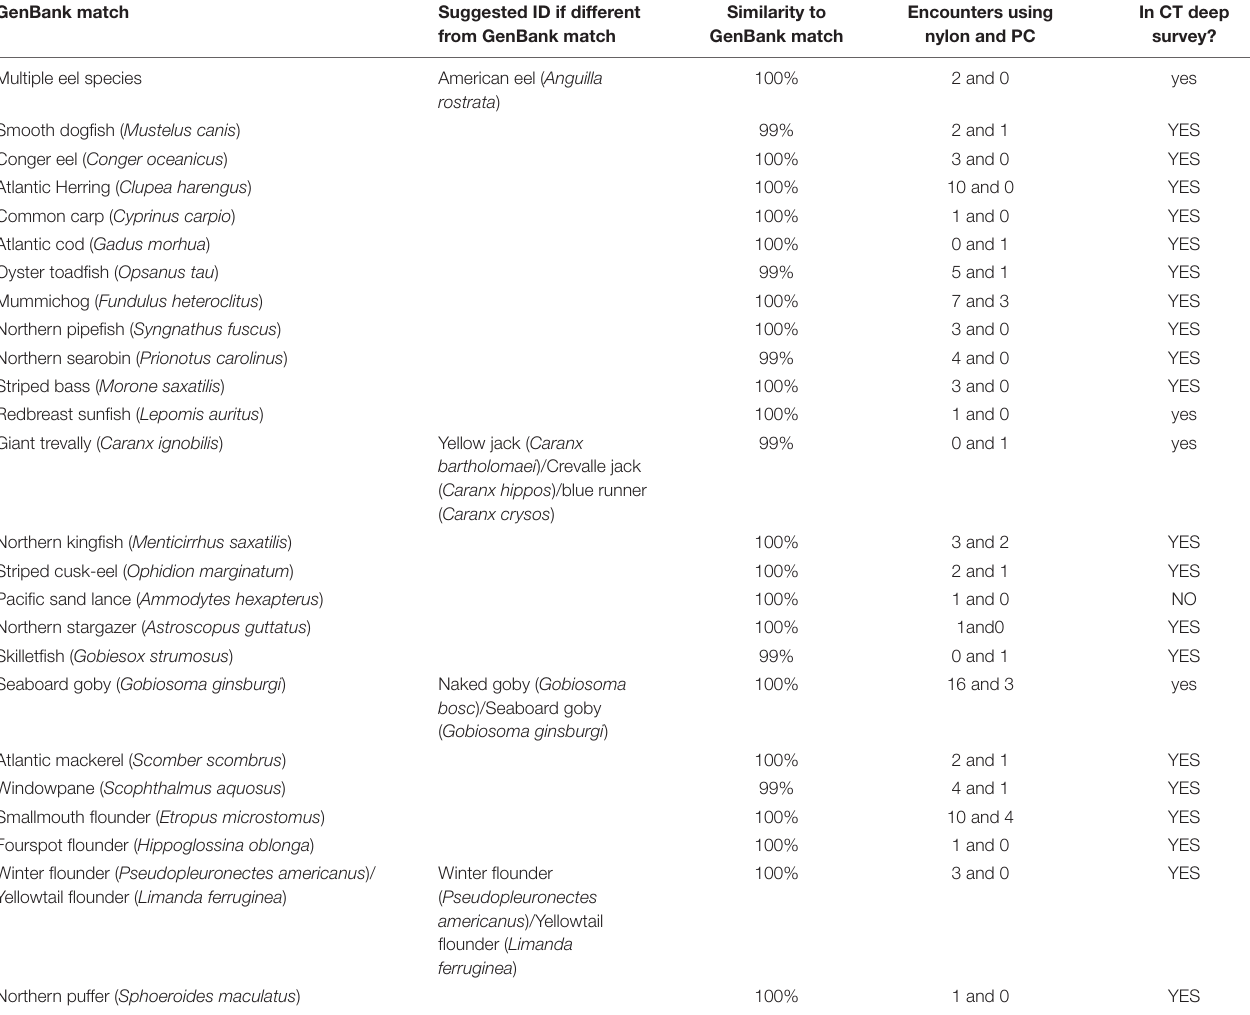
TABLE 3 | Rare fish taxa (represented by < 0.1% ASVs) detected in this study. GenBank